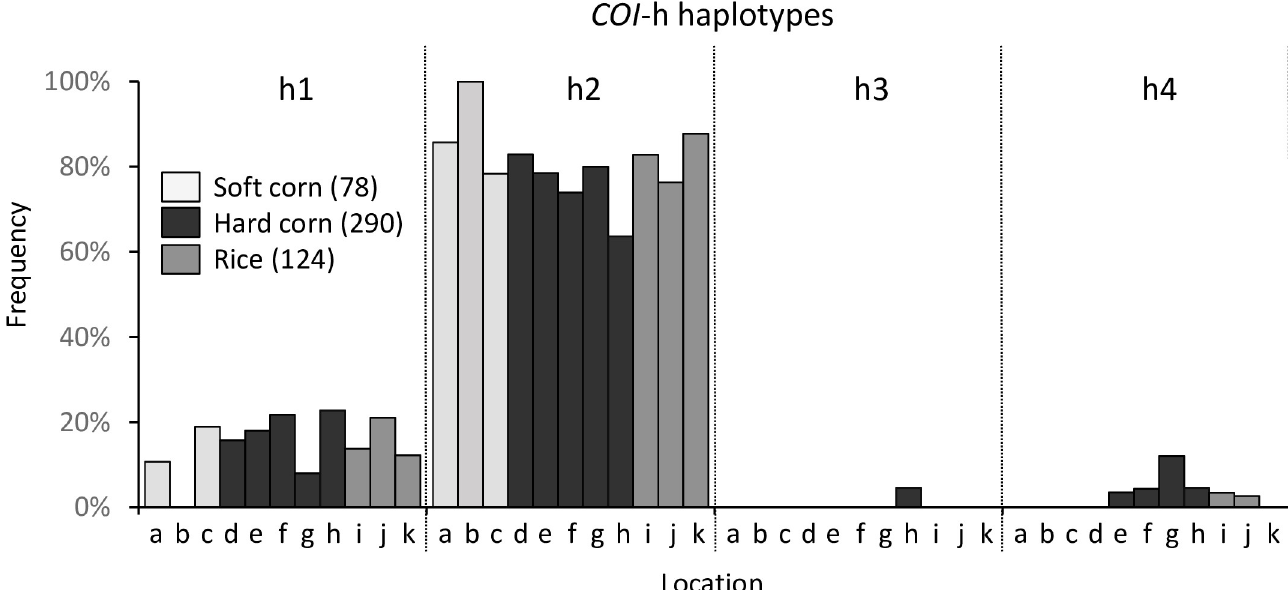
Fig 4. Frequency distribution of the COI -h haplotypes relative to host plants and location. The COI -CS group can be subdivided into four subgroups designated as the COI -h haplotypes. Letters on the x-axis denote provinces (from Table 1) and are organized by haplotype category. Numbers in parentheses indicate the number of specimens from each host